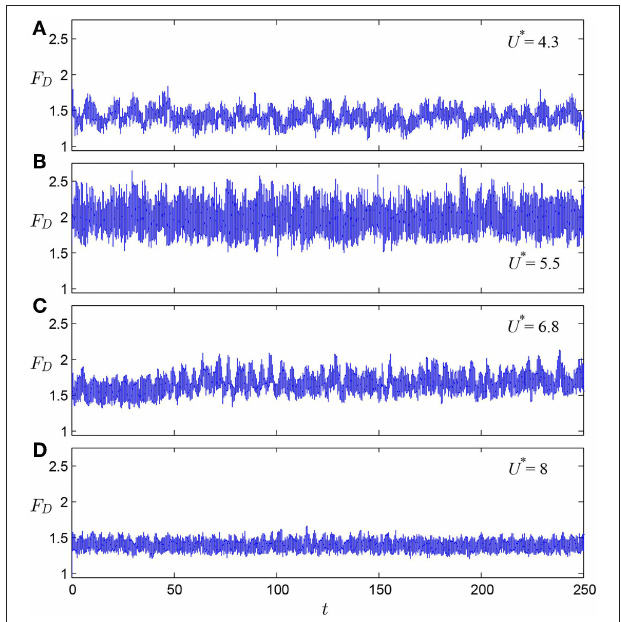
FIGURE 4 | Time series of the drag component at different reduced velocities: (A) U ∗ 4.3 (initial branch), (B) U ∗ 5.5 (upper branch), (C) U ∗ = = (transition), and (D) U ∗ 8 (lower branch). =